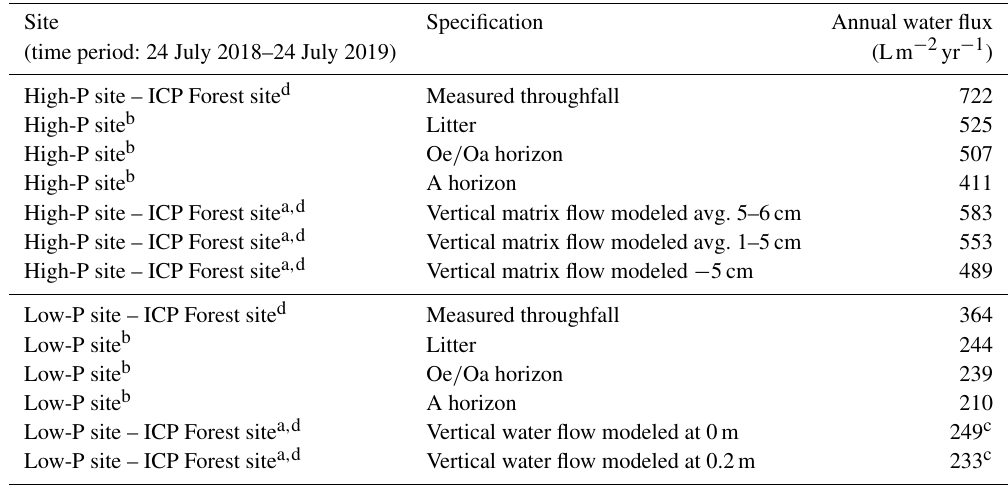
Table 2. Annual water fluxes measured by zero-tension lysimeters below the litter horizon, the Oe / Oa horizon, and the A horizon at the high-P site and the low-P site from July 2018 to July 2019. For comparison, the modeled fluxes from the same sites (both ICP Forest level II sites) are presented. Details are in Sect. S7 in the